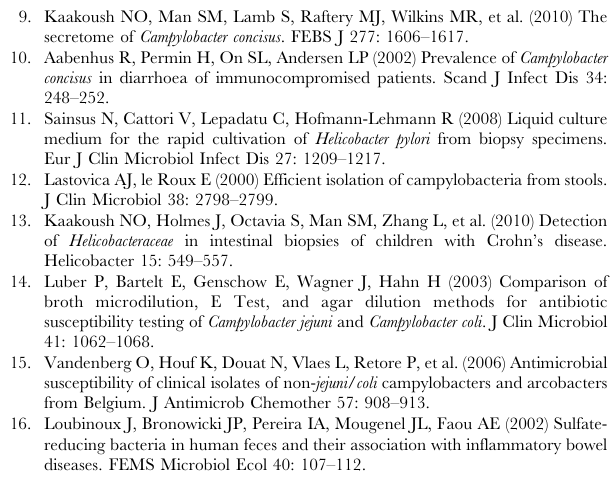
Figure S1 Network associated with the production of IL- 12 generated through IPA H (Ingenuity Systems). Proteins colored in grey were upregulated. Proteins highlighted with an asterisk were directly associated with the IL-12 complex. (PPT) Figure S2 Network associated with the upregulation of Akt generated through IPA H (Ingenuity Systems). Proteins colored in grey were upregulated. Proteins highlighted with an asterisk were associated with one pathway that lead to the expression of Akt. Table S1 Mass spectrometry results of Caco-2 cell proteins whose expression is upregulated in the pres- ence of Campylobacter concisus UNSWCD. Proteins with changes in their intensity $ 2.0-fold ( P , 0.05) were identified by tandem mass spectrometry analyses. Cut off scores of . 58 and $ 2 peptide matches were employed. Table S2 Mass spectrometry results of Caco-2 cell proteins whose expression is downregulated in the presence of Campylobacter concisus UNSWCD. Proteins with changes in their intensity # 0.5-fold ( P , 0.05) were identified by tandem mass spectrometry analyses. Cut off scores of . 58 and $ 2 peptide matches were